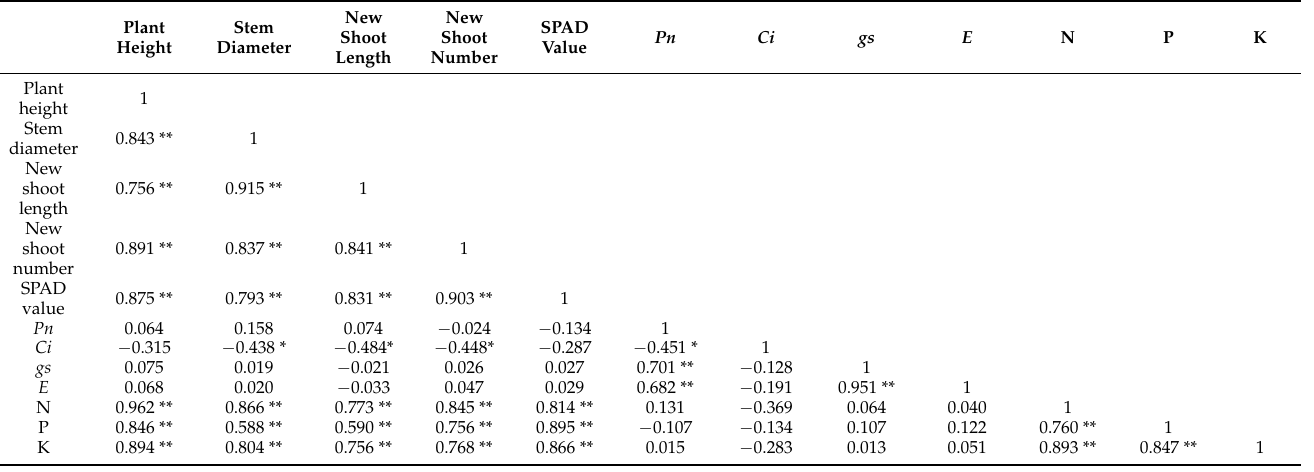
Table 3. Correlation analysis of growth traits, photosynthetic index, and nutrition elements of ‘Misty’ grown in a plant factory with artificial